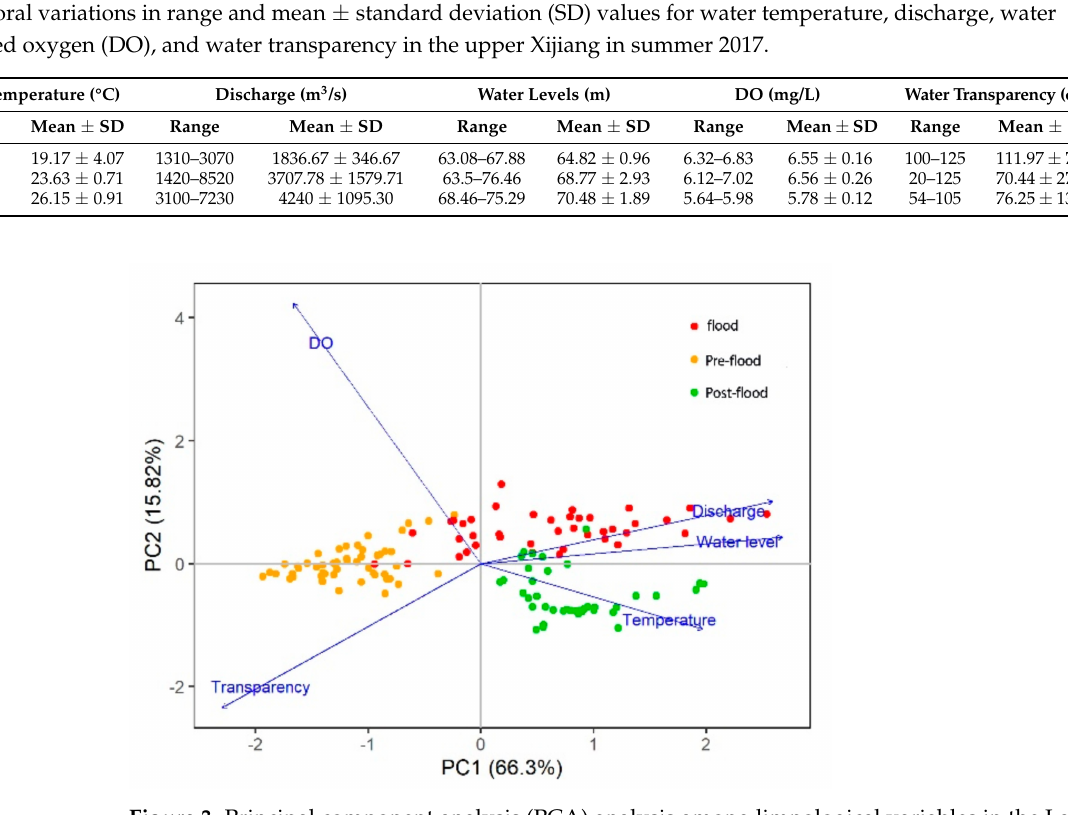
Figure 3. Principal component analysis (PCA) analysis among limnological variables in the Laibin section of the Pearl River during the summer of